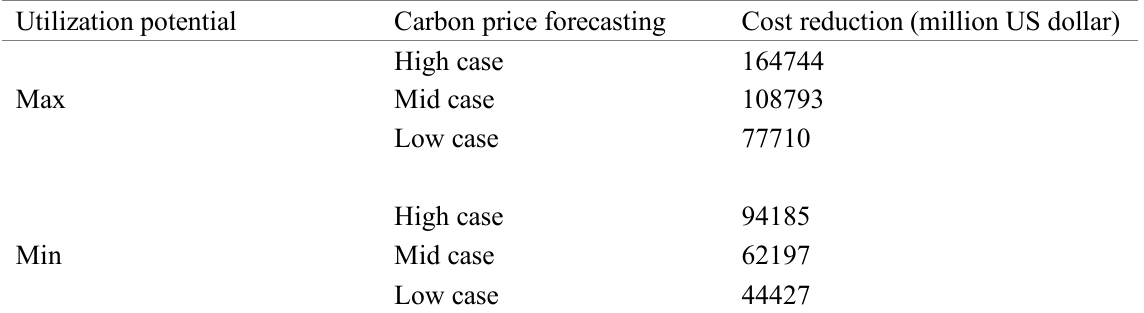
Table 2. Effect of global wind energy utilization on carbon cost reduction in 2030